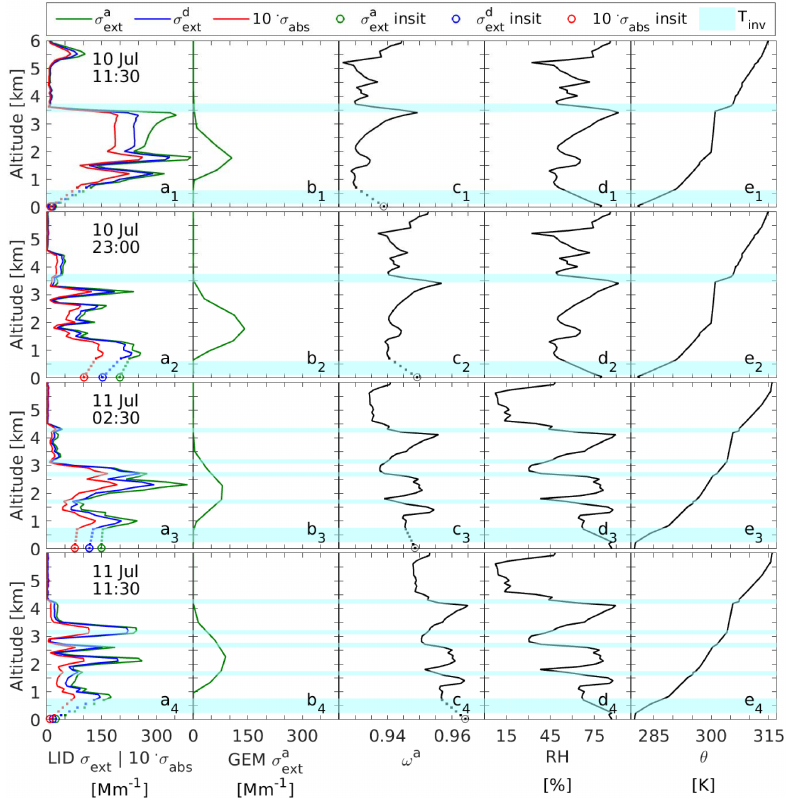
Figure 2. Vertical profiles of aerosol single-scattering properties at 530nm on 10 and 11 July 2015 (UTC), based on the lidar measurements, radio-sounding profiles, and model output (lines), as well as in situ measurements (dots). Subfigures include lidar-derived (LID) extinction coefficient at ambient ( σ a ext ; green) and dry ( σ d ext ; blue) conditions, as well as absorption coefficient σ abs multiplied 10 times (red; a 1–4 ), modelled extinction profile from GEM-AQ (GEM σ a ext ; b 1–4 ), retrieved single-scattering albedo ω a ( c 1–4 ) at ambient conditions, radio- sounding profiles of relative humidity RH ( d 1–4 ), and potential temperature θ ( e 1–4 ). Blue transparent layers denote temperature inversions ( T inv